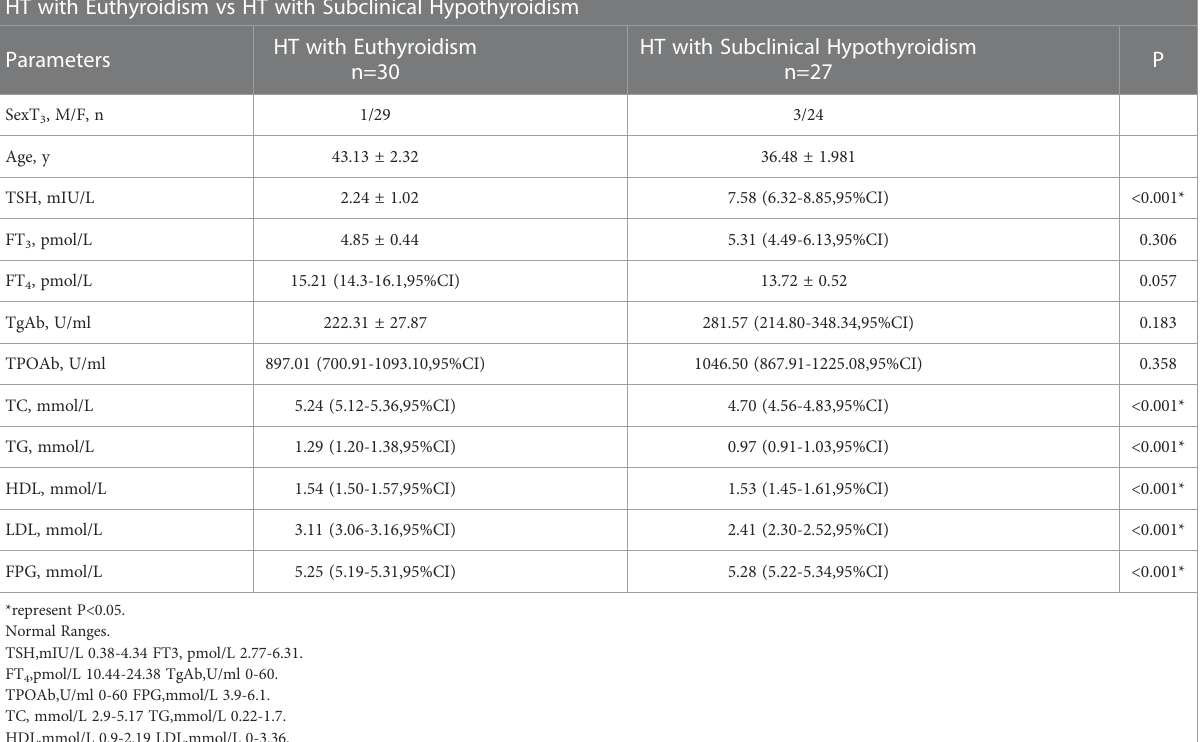
TABLE 3 The clinical baseline parameters of the HTE and HTS group. HT with Euthyroidism vs HT with Subclinical Hypothyroidism